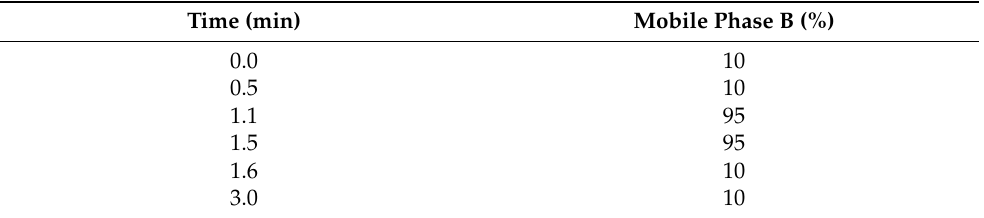
Table 1. The LC gradient elution for the separation of desulfurated DM1. Time